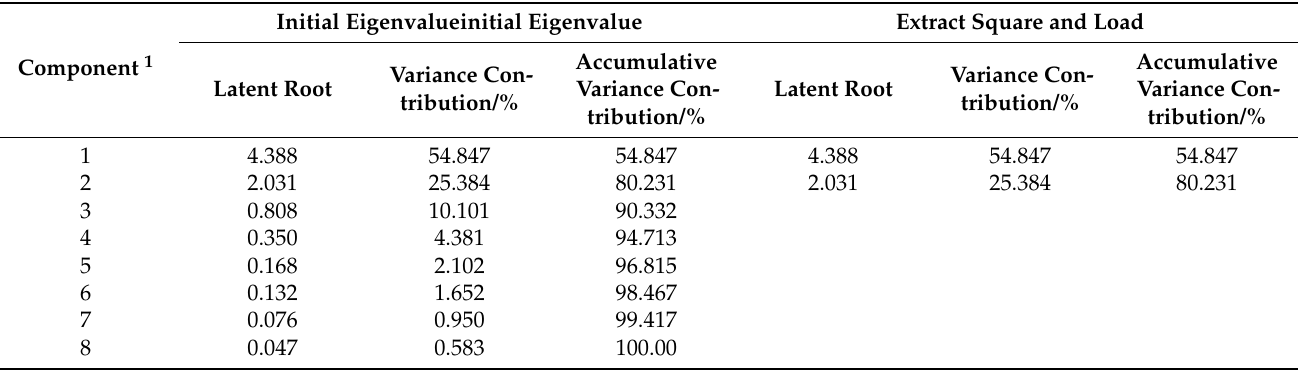
Table 2. Principal component analysis of quality indicator in golden pompano fillets during storage.